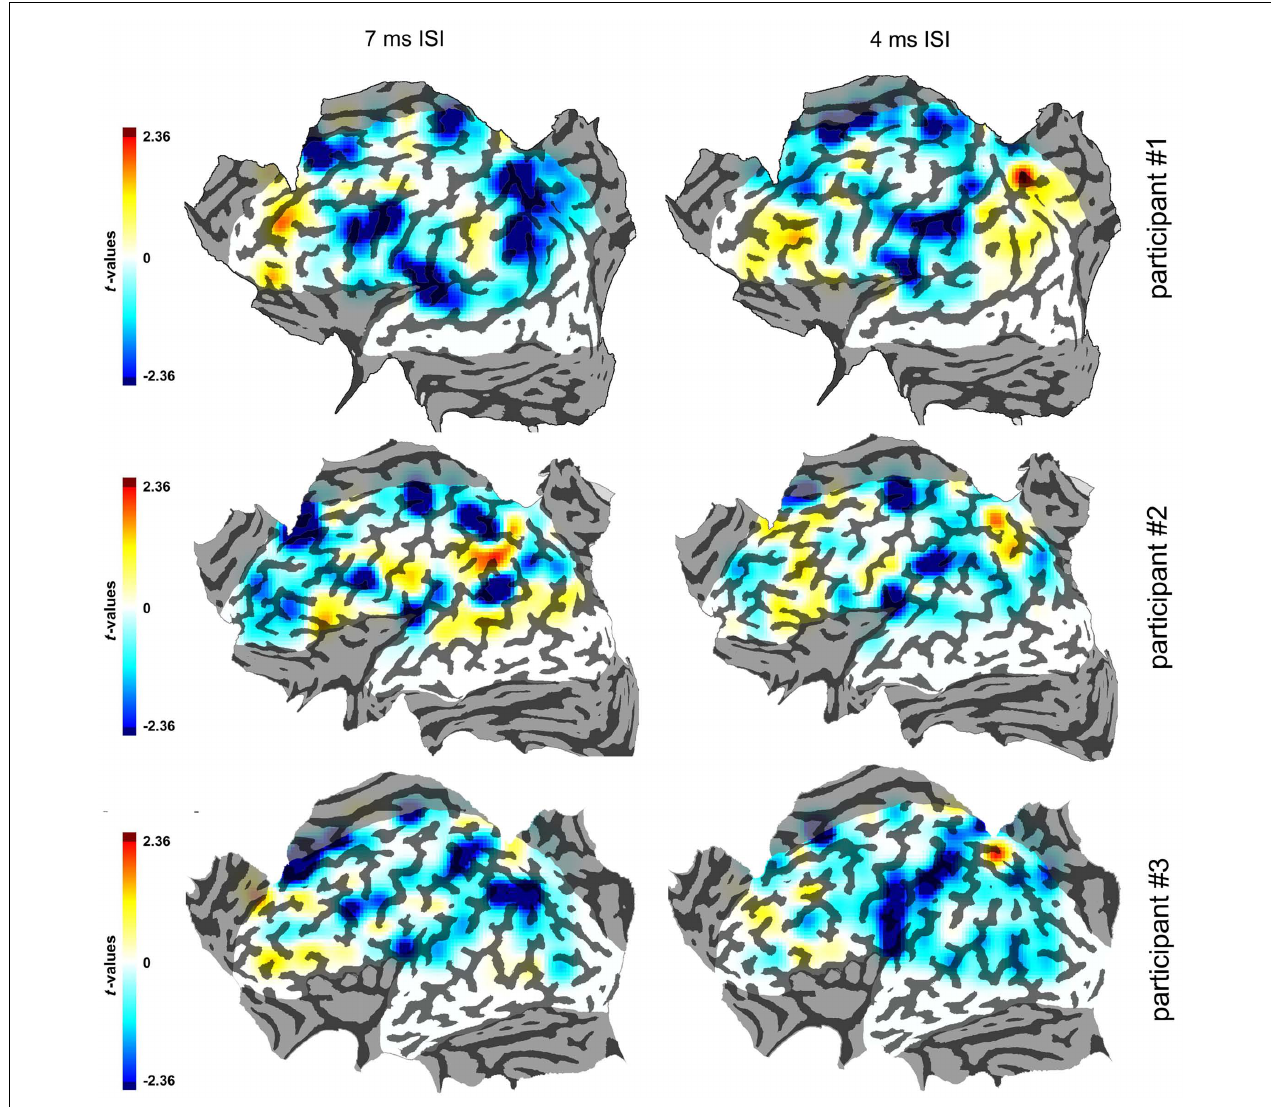
FIGURE 5 | Smoothed maps of the three participants in the 7 and 4ms ISIs. The color scale indicates the values of the statistical parameter t . Conventions as in Figure 3